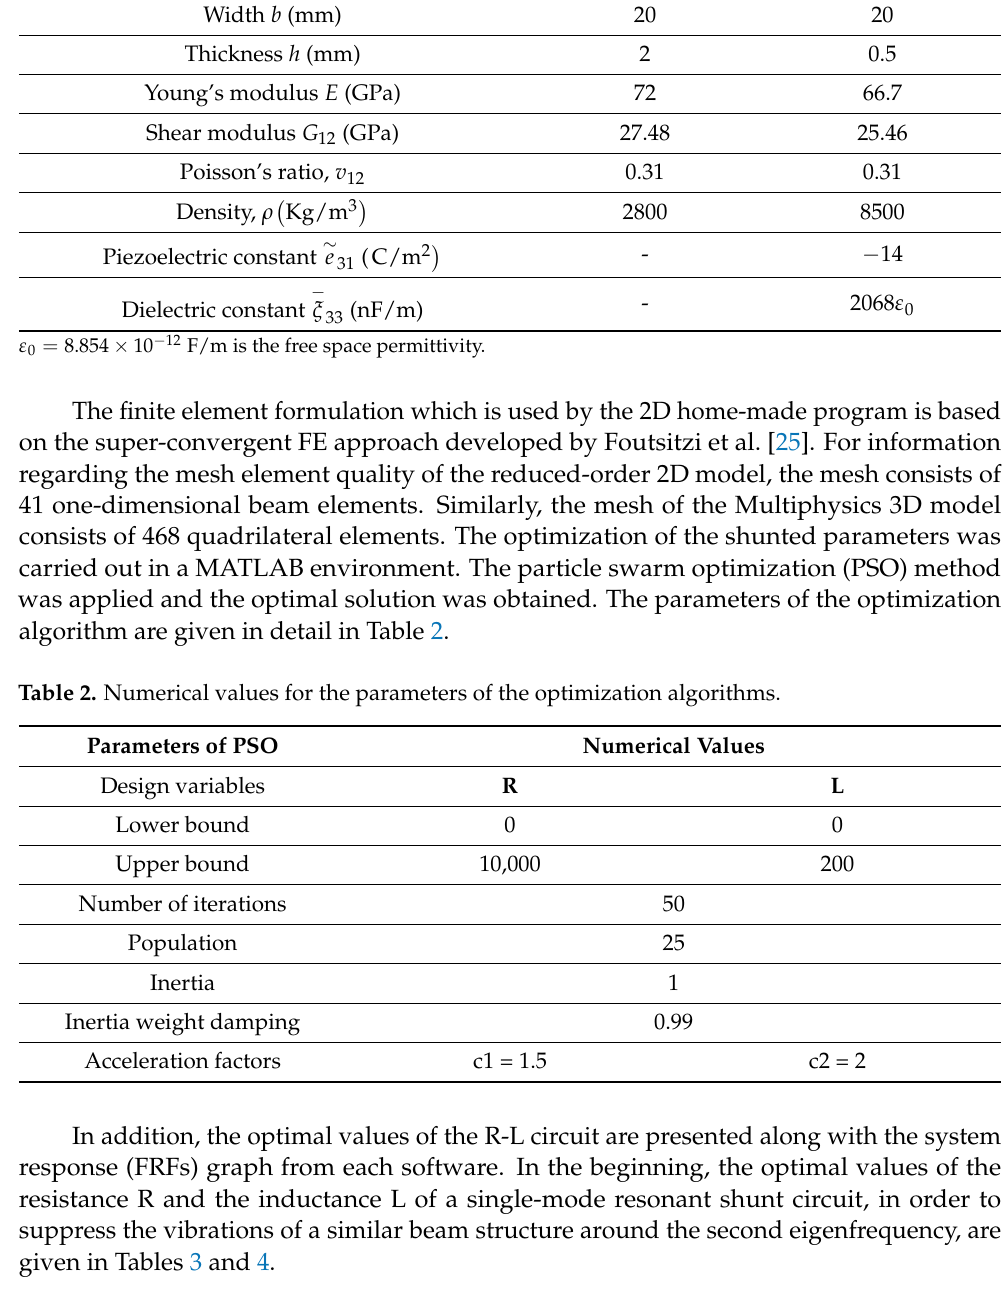
Table 3. Optimal shunt element values based on a 2D FEM